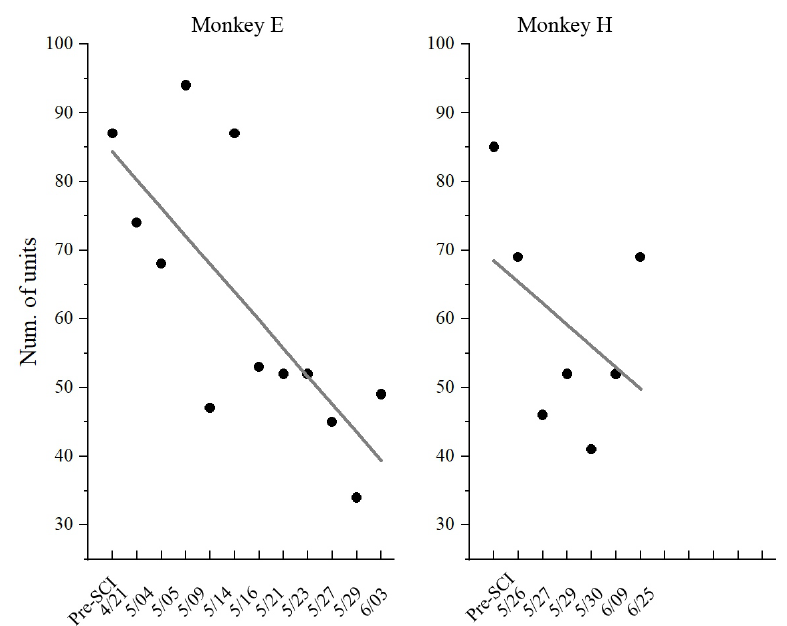
Figure 6. Number of recording units in each session (day). Dots represent individual values; lines represent the linear fitting curve.